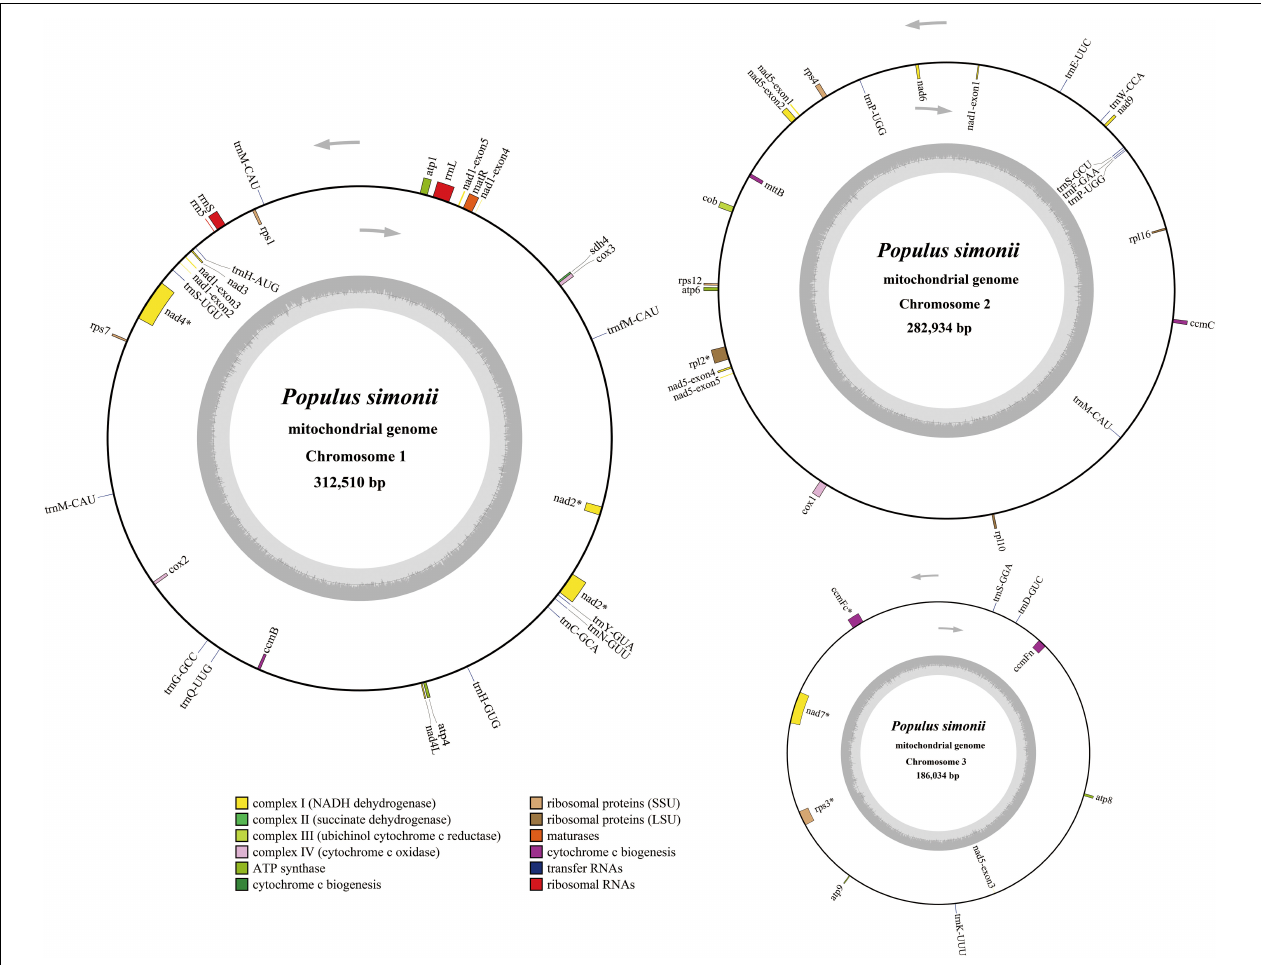
FIGURE 2 | Circular maps of the multi-circular mitogenome of P. simonii . Genomic features on transcriptionally clockwise and counterclockwise strands are drawn on the inside and outside of the three circles, respectively. GC content of each chromosome is represented on the inner circle by the dark gray plot. The asterisks ( ∗ ) besides genes denote intron-containing